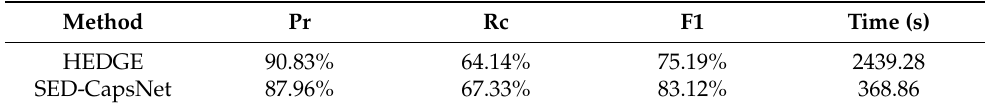
Table 7. A3C vs. HEDGE in encryption